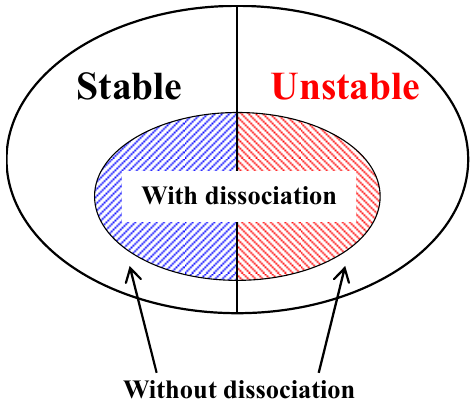
Figure 2. Illustrative view of stable and unstable regions of methane hydrate-bearing sediments with and without